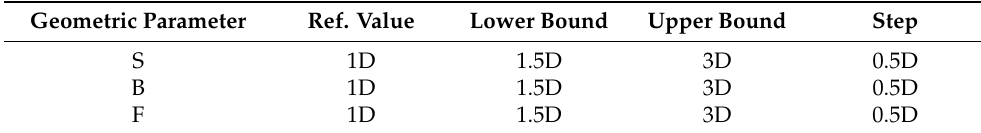
Figure 3. Description of studied parameters: ( a ) inlet flared hole, ( b ) outlet flared hole. Table 1. Geometric parameters of two-head flared